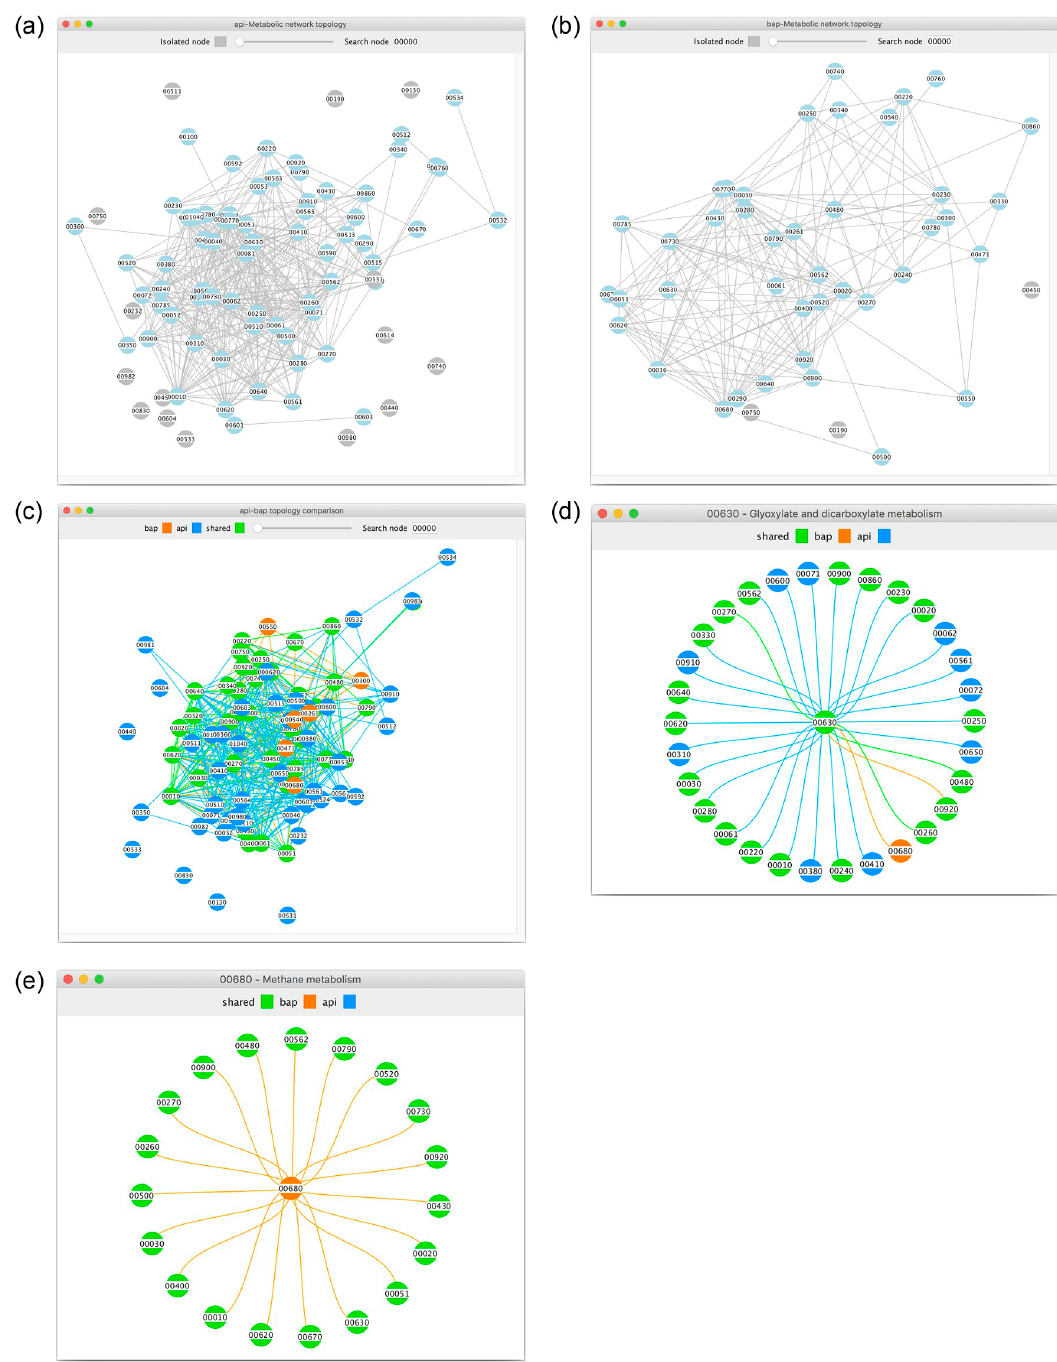
Fig 5. Visual comparison of api and bap at the structural level: (a) api metabolic network; (b) bap metabolic network; (c) api- bap topology comparison; (d) Glyoxylate & dicarboxylate metabolism pathway connections; (e) Methane metabolism pathway